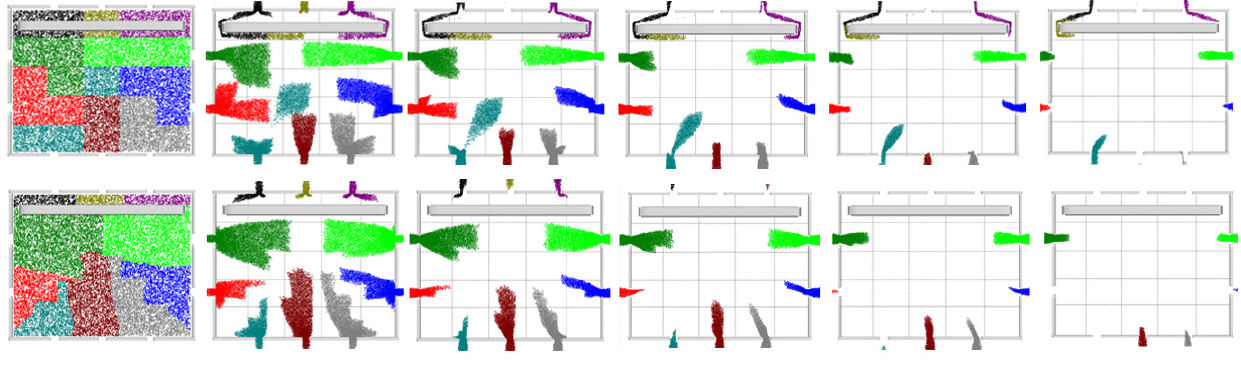
Fig. 20 Evacuation of 25,000 agents with obstacles and safe zones. Agents were simulated even after reaching exits. Top: GA, bottom: our method. Left to right: snapshots at frames 0, 1000, 2000, 3000, and 4000. In the GA method, the agents in the same subregion moved to the same exit. Thus, some agents below the obstacle took a long route to move to exit